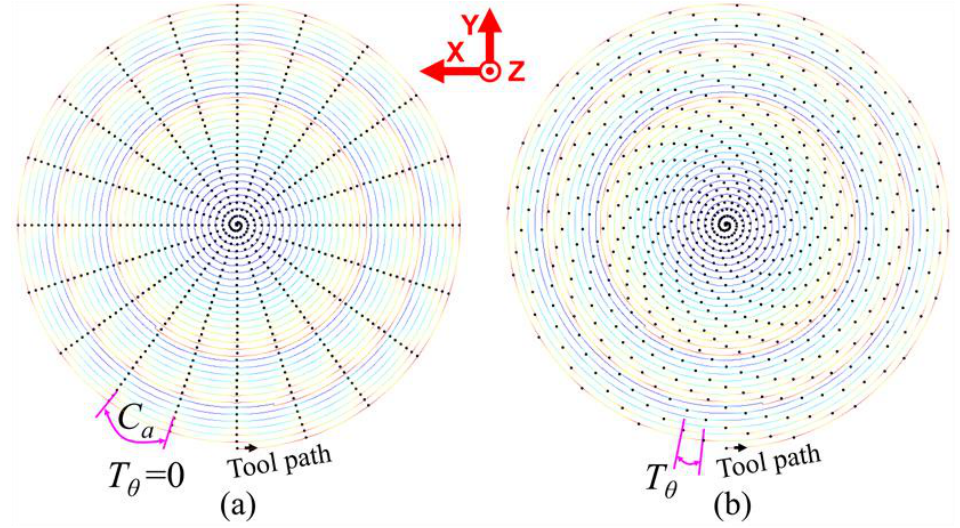
Figure 5. Grinding tool path and the wave-shift value of the Fresnel micro-structured mold: ( a ) the integer rotation speed ratio (RSR); ( b ) the non-integer RSR.